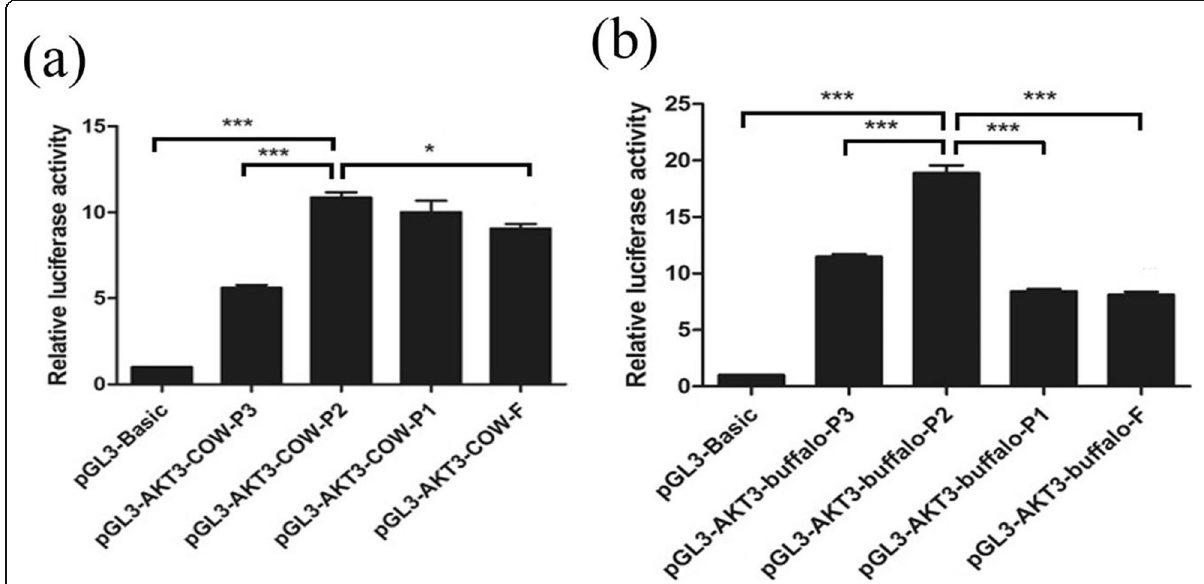
Fig. 5 a The documentation and identification of AKT3 core promoters in cow. These bars in 293T cells represent the comparative luciferase activities of the promoter fragments. b The certification, identification, and documentation of AKT3 core promoters in buffalo. These bars in 293T cells represent the comparative luciferase activities of the promoter fragments. The values are represented as mean ± standard deviation. The standard deviations signified with the error bars respectively. To detect and clarify by using unpaired student ’ s t -test for significant differences as * P < 0.05, ** P < 0.01, and *** P < 0.001. ( n =